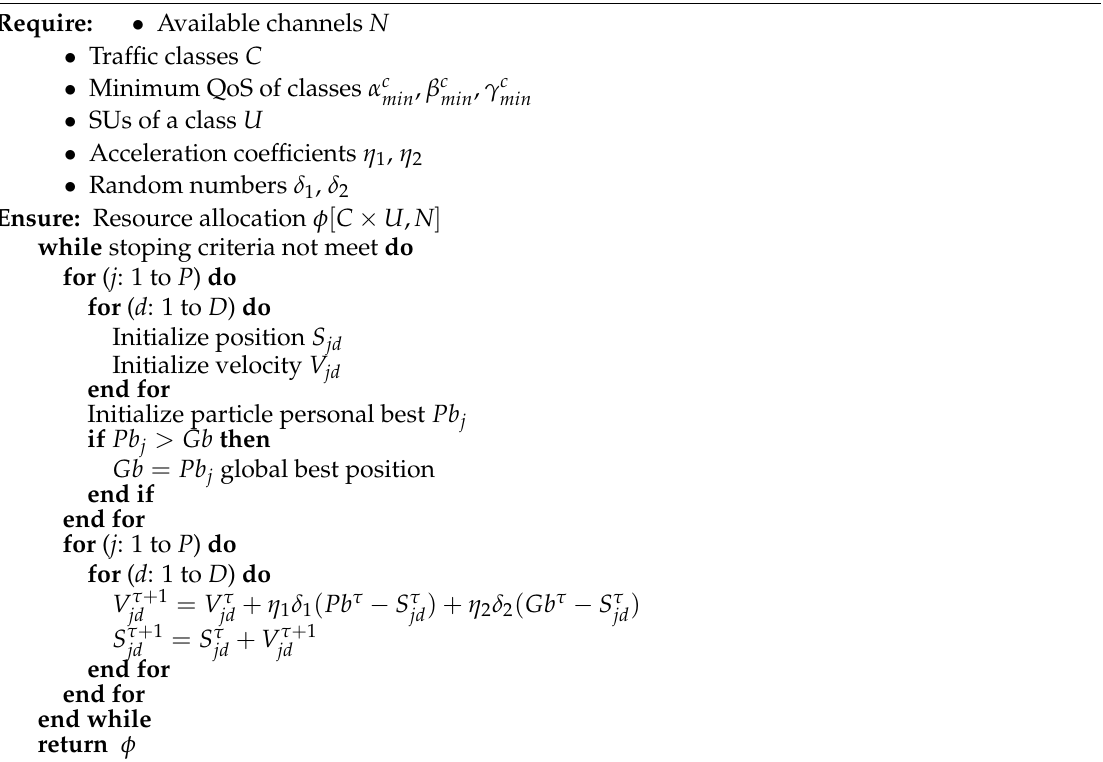
Algorithm 1 PSO-based device-centric QoS provisioning for SUs in a smart